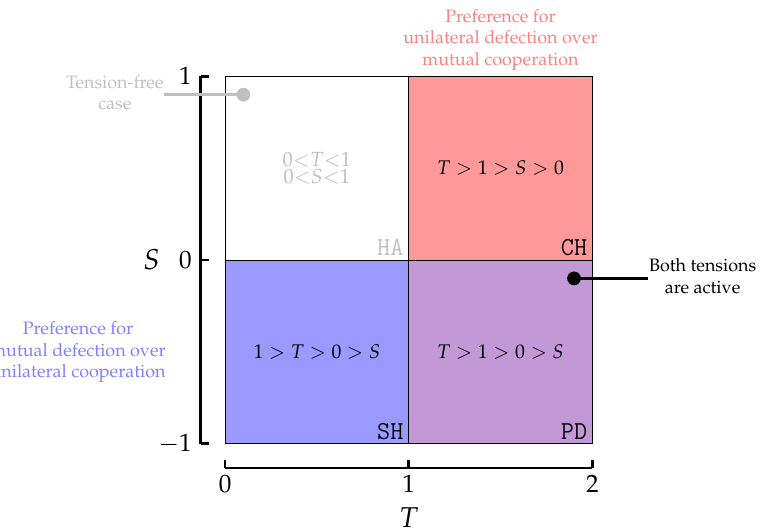
Figure 1. Different game types according to the values of parameters T and S